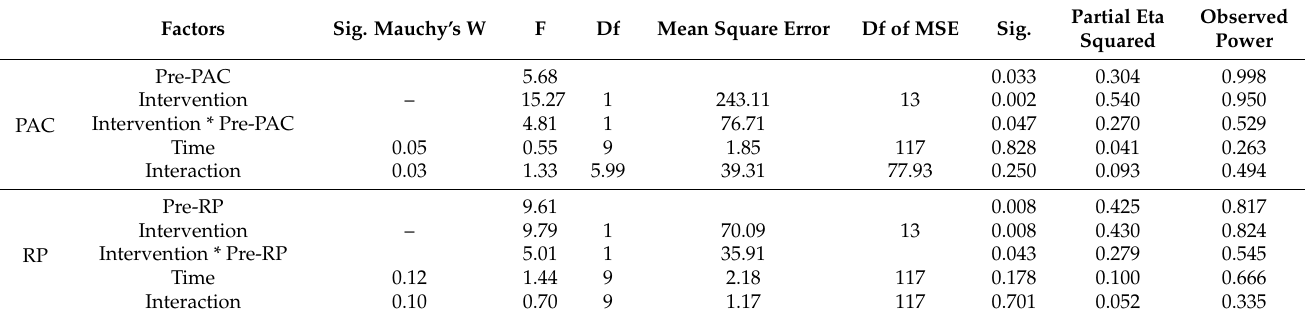
Table 3. Two-way repeated measures ANCOVA of some coping strategies with